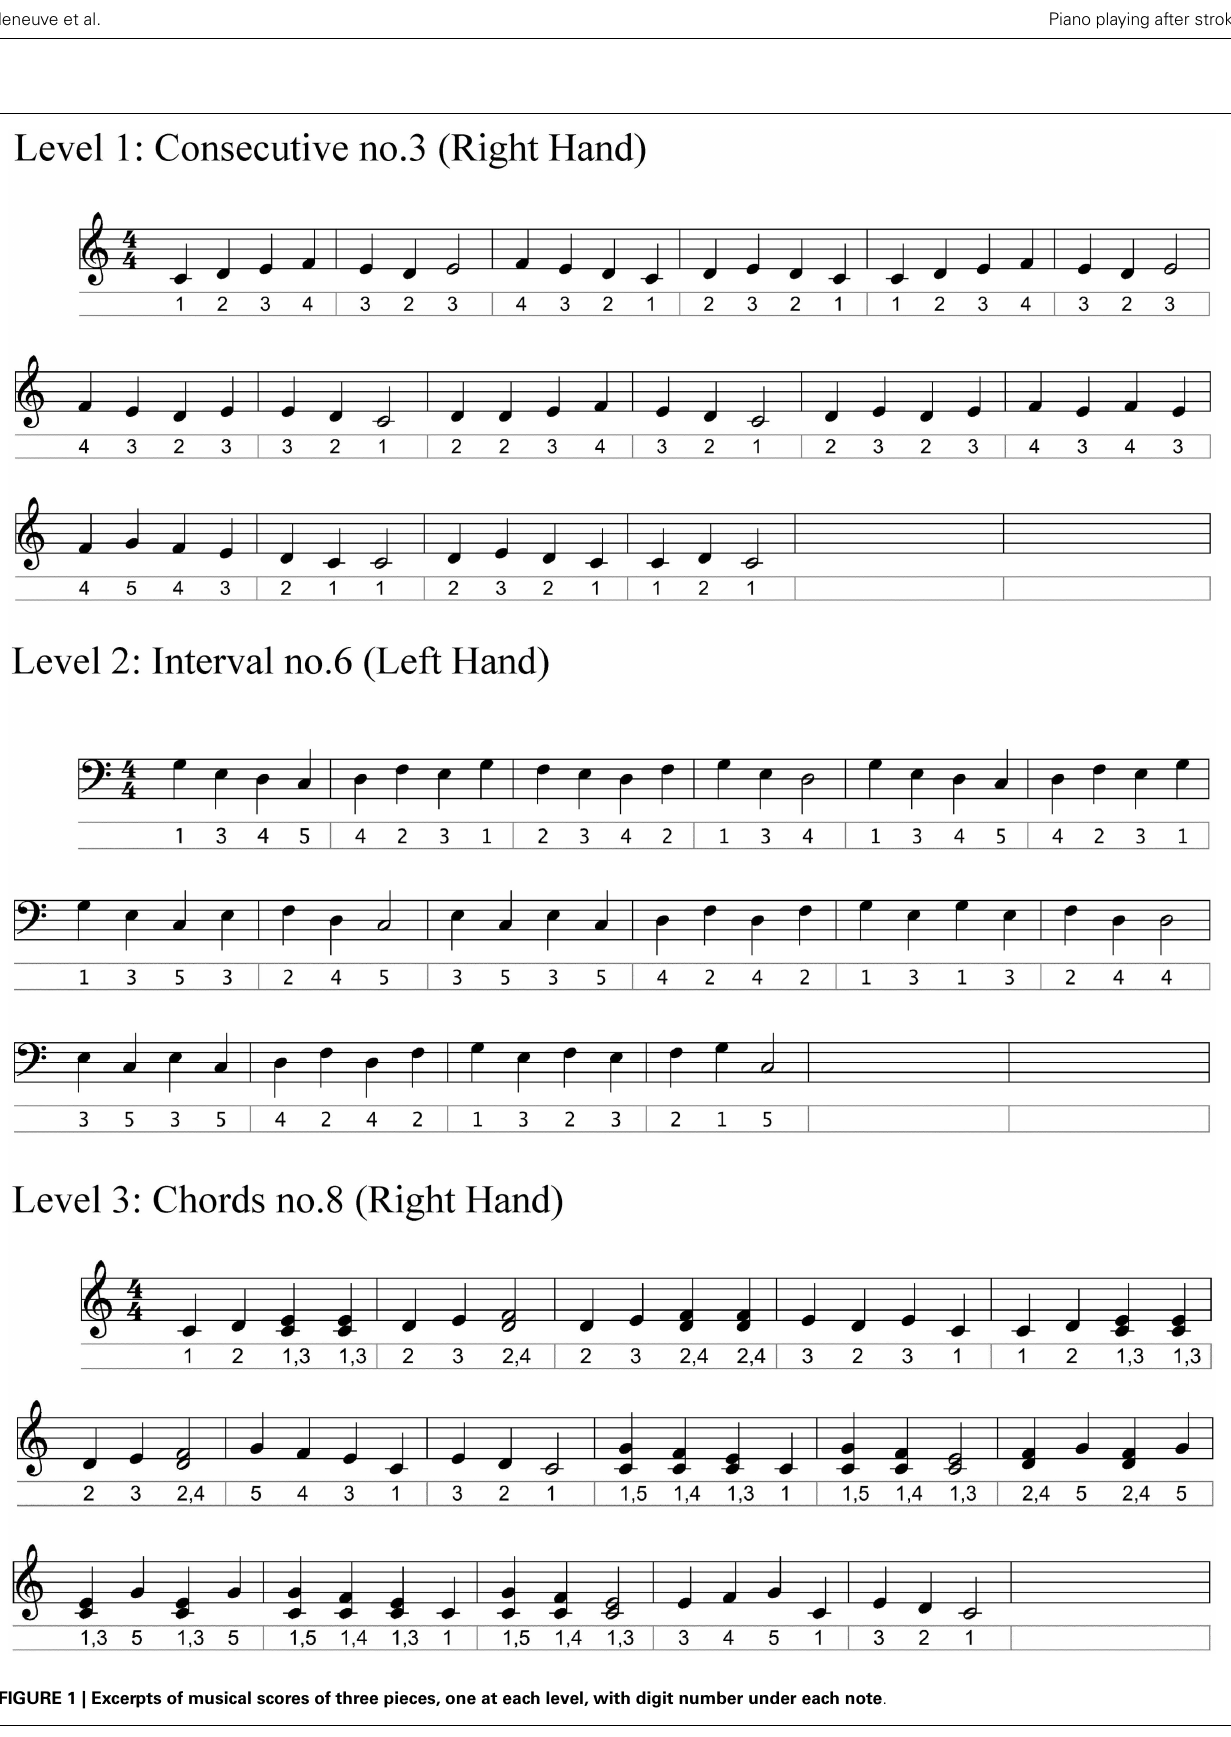
Frontiers in Human